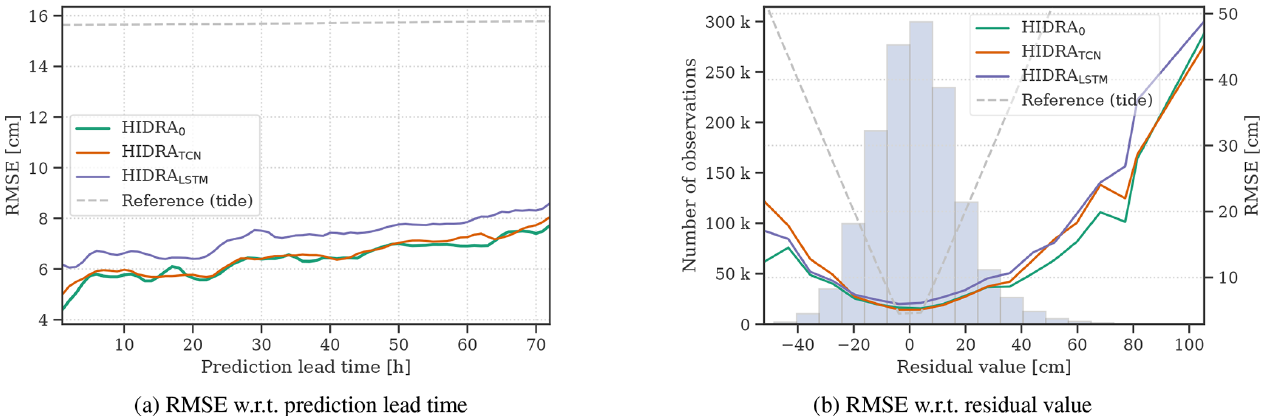
Figure 7. Comparison of different temporal encoder variants. HIDRA 0 is compared with more complex variants using different temporal encoders: LSTMs (HIDRA LSTM ) and TCNs (HIDRA TCN ). The RMSE with respect to (a) prediction lead time and (b) residual values is shown. The prediction errors using the astronomic tide are presented for reference.